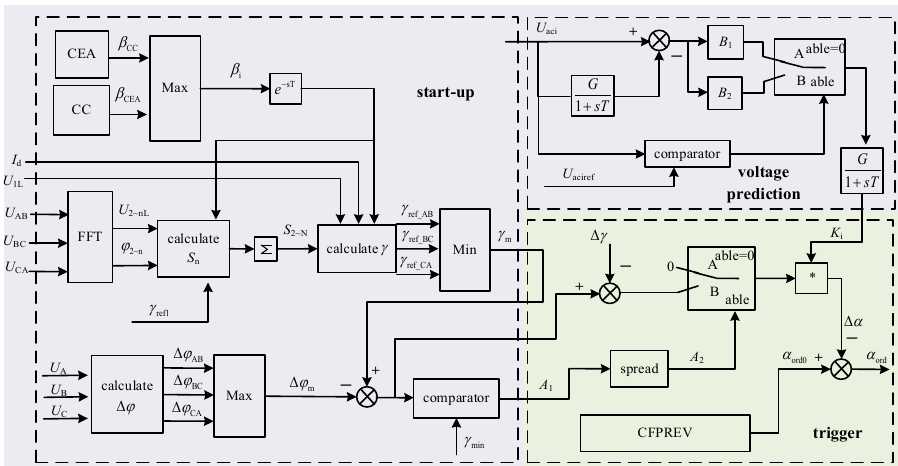
Figure 10. Principle block diagram of commutation failure suppression strategy considering harmonic and voltage prediction.